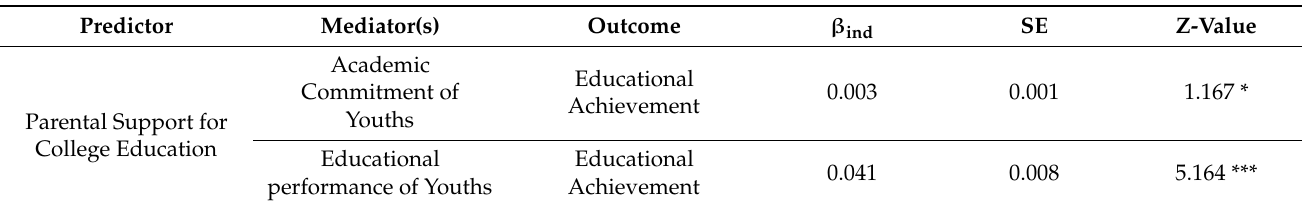
Table 4. Mediated Effects of Youths’ Grade-8 Academic Commitment and Grade-9 Educational Performance on the Relationships of Grade-7 Parental Support for College Education, Family SES, and Educational Expectations of Youths in prediction of Educational Achievement of Youths in Adulthood (Model